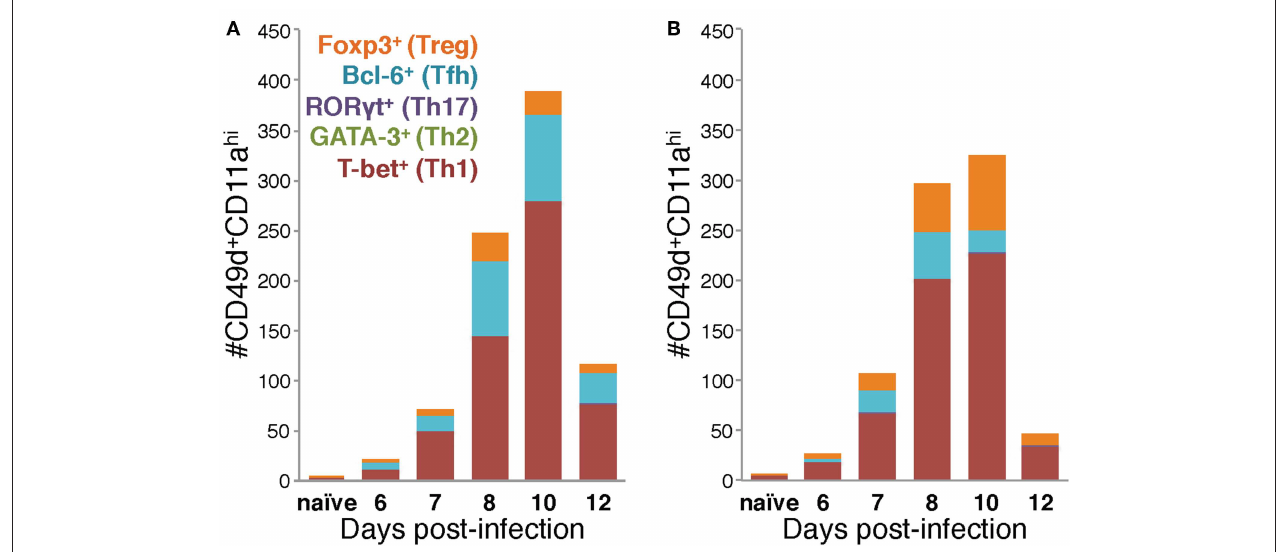
FIGURE 5 | Differences in the Th subset composition of the IAV-specific CD4T cell compartment in the lungs of BALB/c and C57Bl/6 mice during infection. Number of IAV-specific CD4T cells corresponding to each of the indicated Th subsets in the lungs of IAV-infected C57Bl/6 (A) and BALB/c (B) mice based on their transcription factor